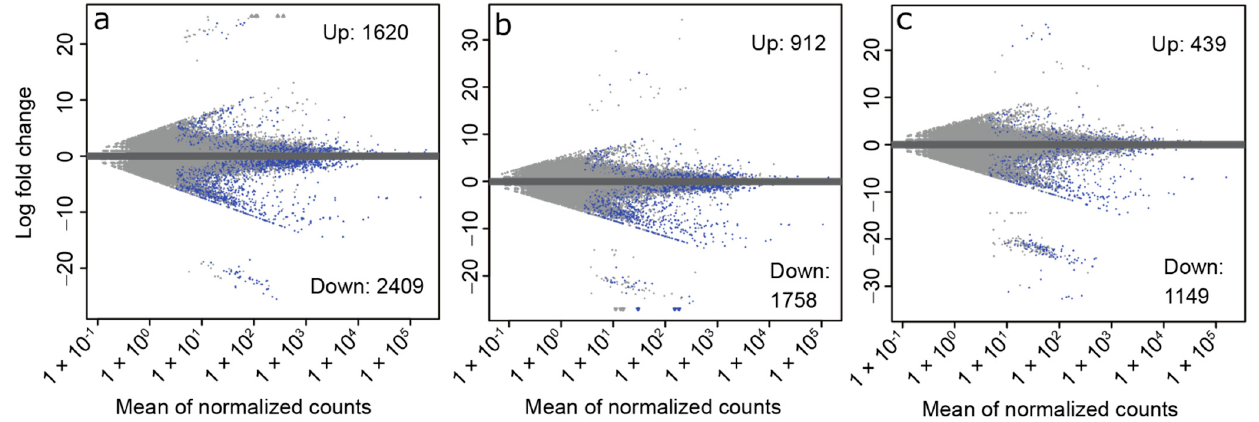
Figure 1. Principle Component Analysis (PCA) score plots of samples. This PCA was used to deter- mine the relationship between transcript expression profiles from various stages of diapause. One of the mid-diapause samples was removed from the dataset prior to this analysis due to technical problems with the sample, so there are only three replicates for this group. One LD sample clustered with the ND samples, and that female had already broken diapause and started ovipositing at the time of sample collection. Thus, this sample was removed from further analyses. ED = early dia- pause, LD = late diapause, MD = mid-diapause, ND = non-diapause. To identify transcript expression changes associated with early diapause, we com- pared the ND and ED groups. In this comparison, there were 1620 upregulated and 2409